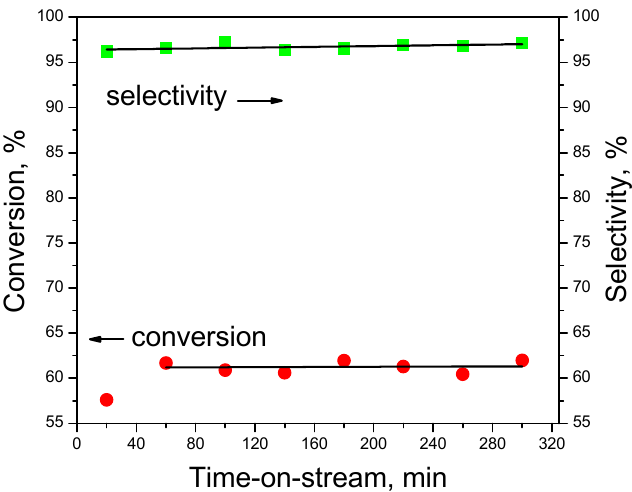
Figure 7. Stability test with the Ni/CN-1073 catalyst at 573 K.